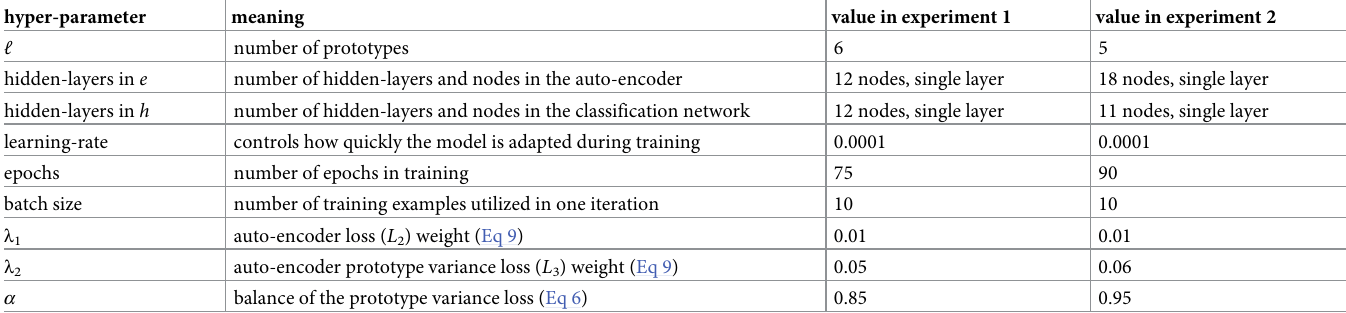
Table 5. Hyper-parameters of the DPNN model in both experiments.